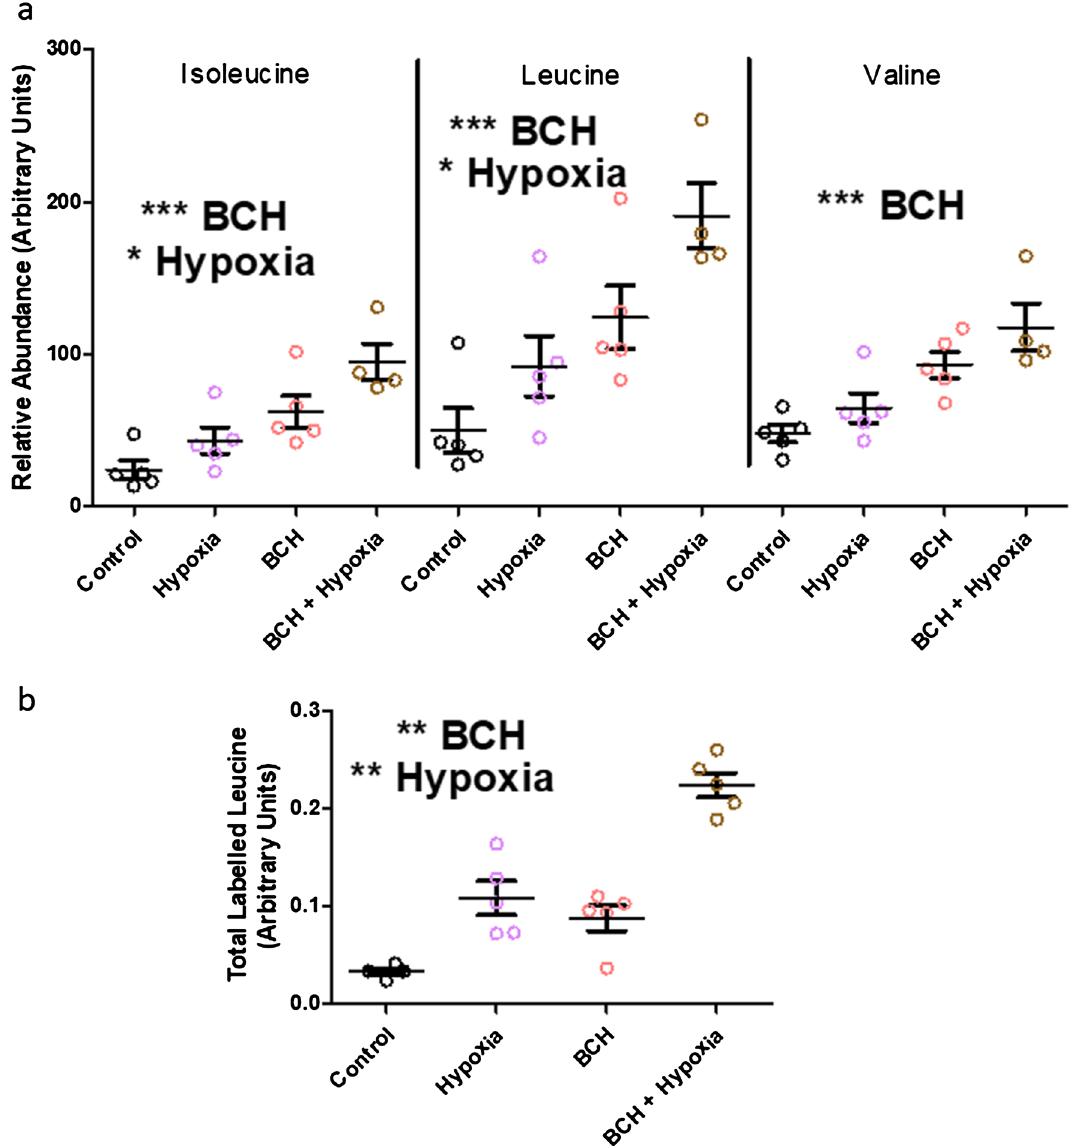
Figure 3. Measurement of candidate metabolites in the supernatant of forebrain slices of control (black), BCH (pink), hypoxia (red) and BCH + hypoxia (gold) groups. ( a ) There was a significant main effect of BCH to increase the abundance of isoleucine (p = 0.0002, f = 22.80), leucine (p = 0.004, f = 19.99) and valine (p = 0.0002, f = 24.28). There was also a significant main effect of hypoxia to increase isoleucine (p = 0.014, f = 7.68) and leucine (p = 0.013, f = 7.91), but not valine (p = 0.056, f = 4.31). There was no evidence for an interaction effect for any of the BCAAs (isoleucine-p = 0.489, f = 0.50; leucine-p = 0.54, f = 0.40; valine-p = 0.70, f = 0.15). ( b ) 13C-leucine concentrations in the supernatant were higher with hypoxia (p = 0.009, f = 9.02) and BCH (p = 0.004, f = 11.62), with no interaction effects (p = 0.715, f = 0.14). ** indicates p < 0.01. *** indicates p < 0.001, adjusted threshold for statistical significance was p < 0.003. Statistical comparisons were made using a 2-way ANOVA. Metabolite abundance was normalised to the spiked in standard 6-Glutaric acid. Error bars indicate standard